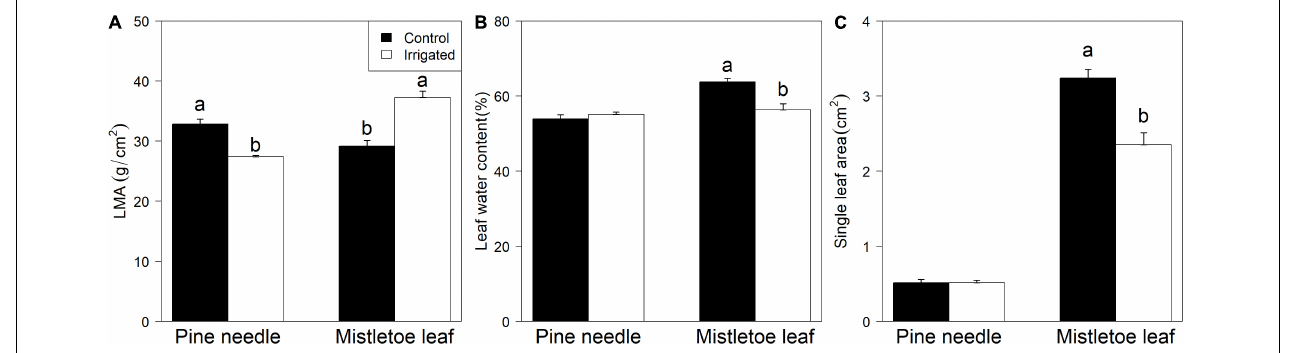
FIGURE 2 | Comparison of the leaf traits between Pinus sylvestris and Viscum album ssp. austriacum in the control and irrigation treatments ( n = 3 trees per treatment). (A) Leaf mass per unit leaf area (LMA) of mistletoe leaves and pine needles, (B) leaf water content of mistletoe leaves and pine needles, (C) single leaf area of mistletoe leaves and pine needles. Different letters indicate significant differences ( P < 0.05) for each tissue between dry controls and irrigated trees.